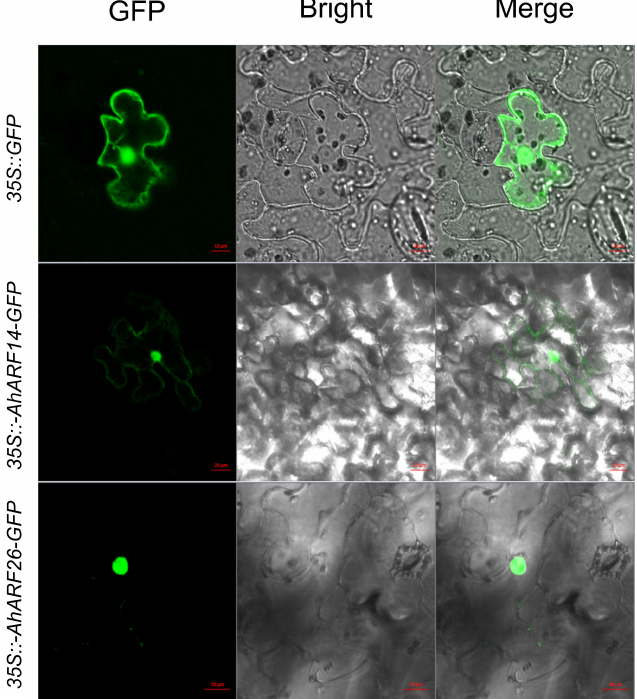
Figure 7. Subcellular localization analysis of AhARFs in N. benthamiana